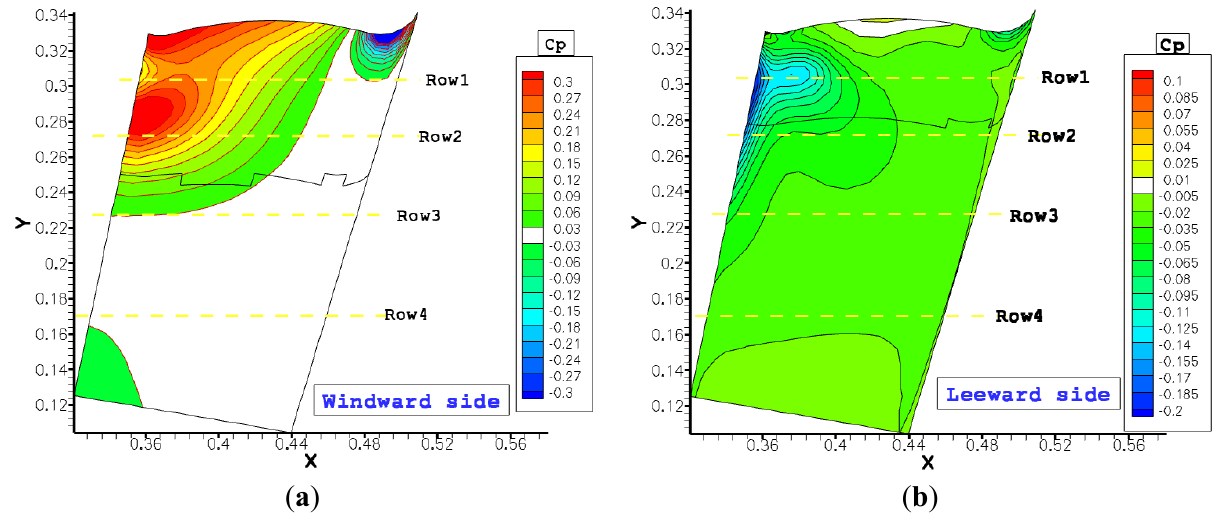
Figure A3. ( a ) CFD pressure contours on windward side of a stator blade. Four rows of pressure taps. And ( b ) CFD pressure contours on leeward side of a stator blade. Four rows of pressure taps.